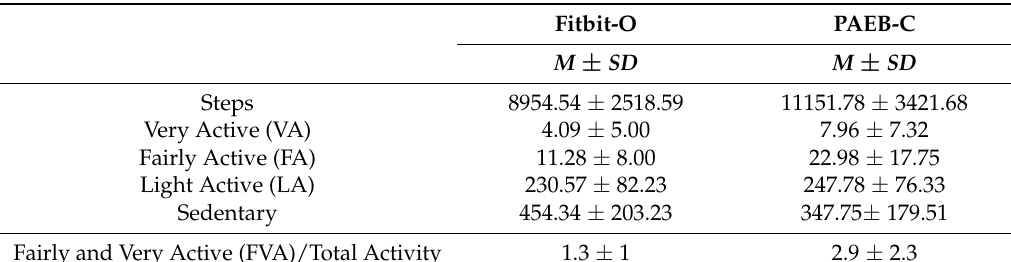
Table 1. Mean steps and minutes of physical activity between the two intervention groups. Fitbit-O, Fitbit Only; PAEB-C, Physical Activity Engaging the Brain + Fitbit